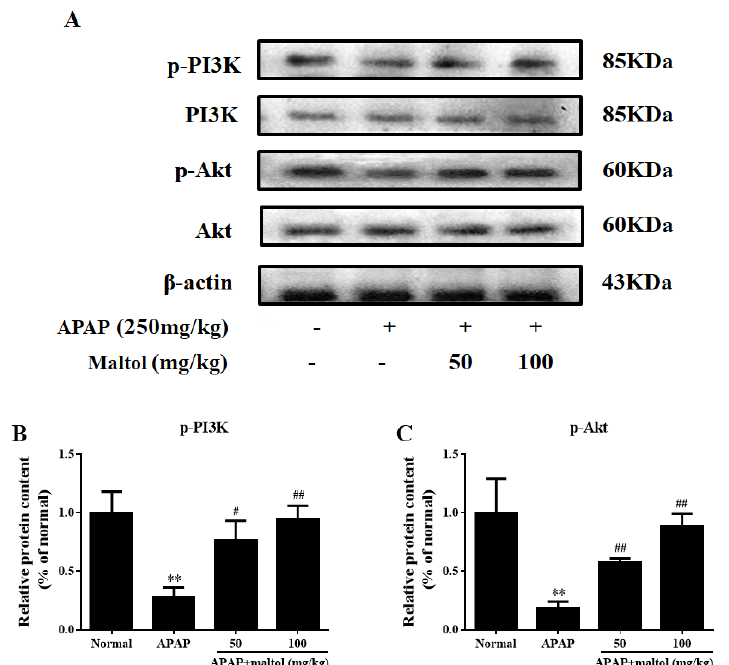
Figure 7. E ff ects of maltol pretreatment on the phosphatidylinositol 3-kinase / protein kinase B (PI3K / Akt) signaling pathway against APAP-induced liver injury. ( A ) The protein expression levels of phosphorylated and total PI3K and Akt were measured by western blotting with specific primary antibodies, and β -actin protein was used as a loading control. ( B , C ) Quantification of relative protein expression levels was performed by densitometric analysis. All data are expressed as mean ± S.D., n = 8. ** p < 0.01 vs normal group; ## p < 0.01, # p < 0.05 vs. APAP group.